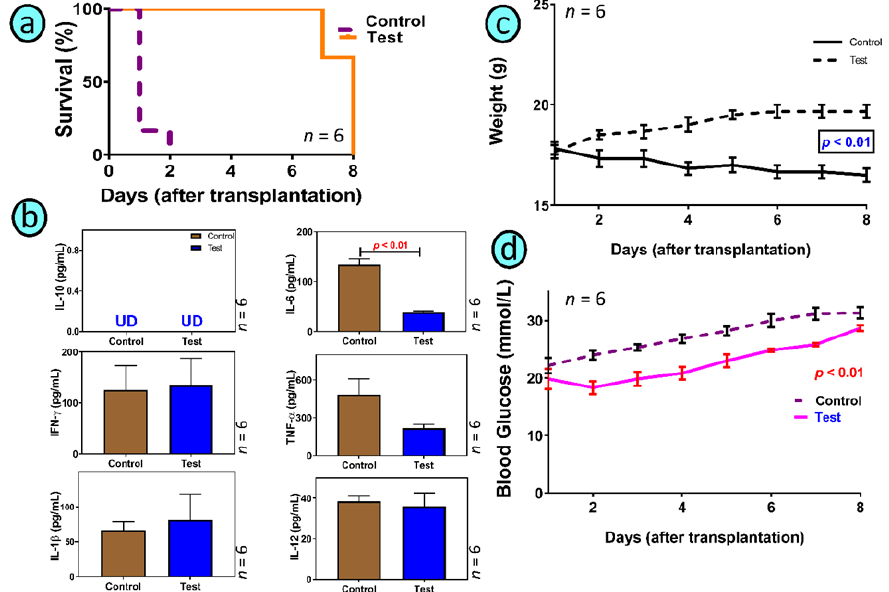
Figure 4. Survival ( a ), plasma cytokine concentrations for IL-10, IL-6, IFN- γ , TNF- α , IL-1 β , and IL-12 ( b ), body weight ( c ) and blood glucose concentrations ( d ). Data are the mean ± SEM.